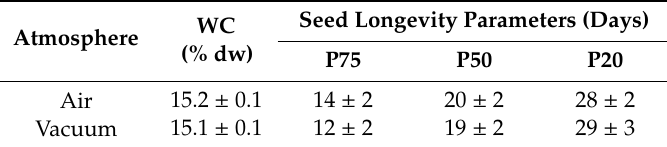
Table 1. Longevity parameters and water content of Secale cereale seeds stored at 35 ◦ C, after equilibration at 75% RH and 20 ◦ C. Deterioration is expressed as the time for seed germination to decrease to 75, 50, and 20% of initial germination. Data are expressed by mean values ± standard error. n = 4 replicates of 25 seeds